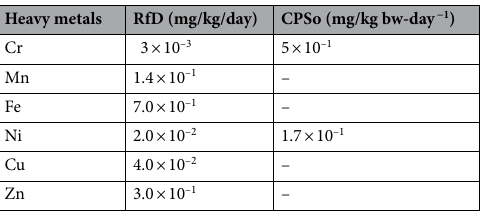
Table 5. Reference dose (RfD) and carcinogenic potency slope oral (CPSo) of heavy metals. Adapted from USEPA 2011,